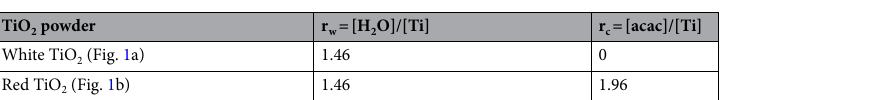
TiO 2 powder r w = [H 2 O]/[Ti] r c = [acac]/[Ti] White TiO 2 (Fig. 1a) 1.46 0 Red TiO 2 (Fig. 1b) 1.46 Table 1. Hydrolysis and complexation ratios used for the synthesis of the standard (white) and the oxygen vacancy-rich (red) amorphous TiO 2 particles.